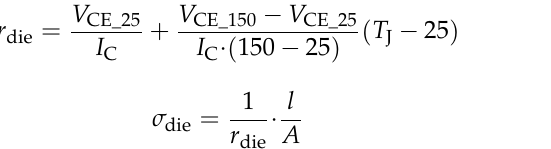
Table 2. Material properties of the FEM model.